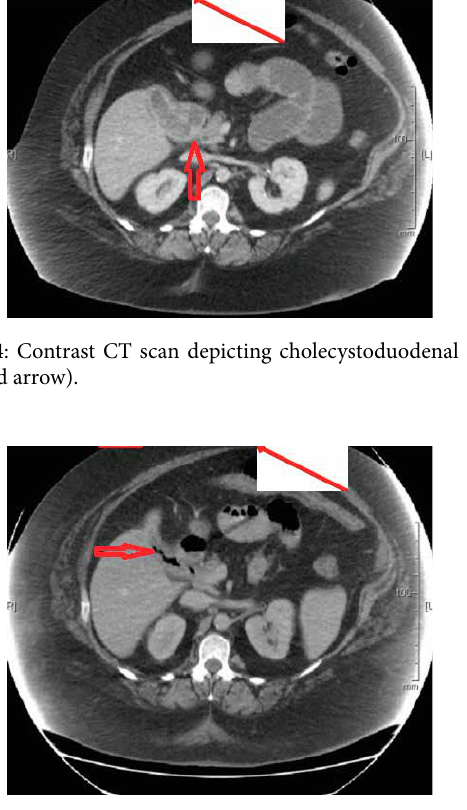
Figure 5: CT contrast scan depicting decompressed GB and air in GB, verifying that a stone was released (short red